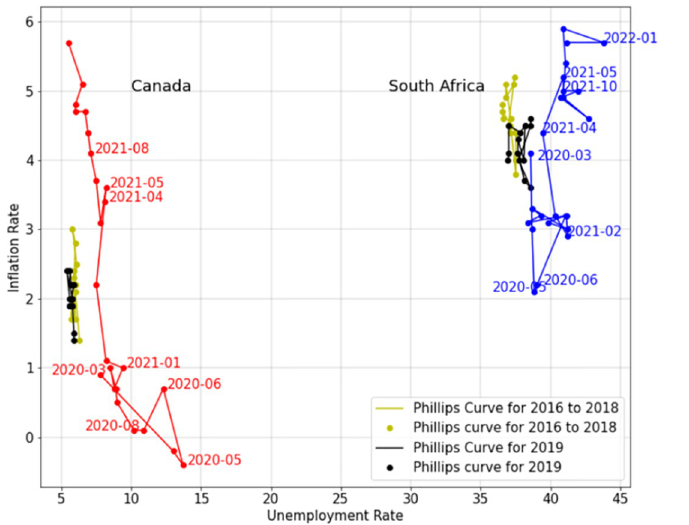
Fig 3. Phillips curve. Phillips curve of Canada and South Africa.